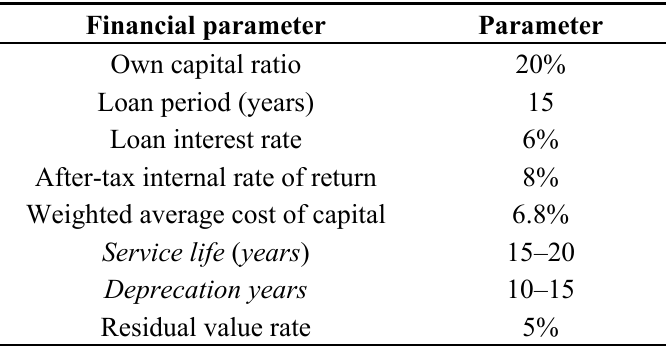
Table 2. Financial factors of a wind power